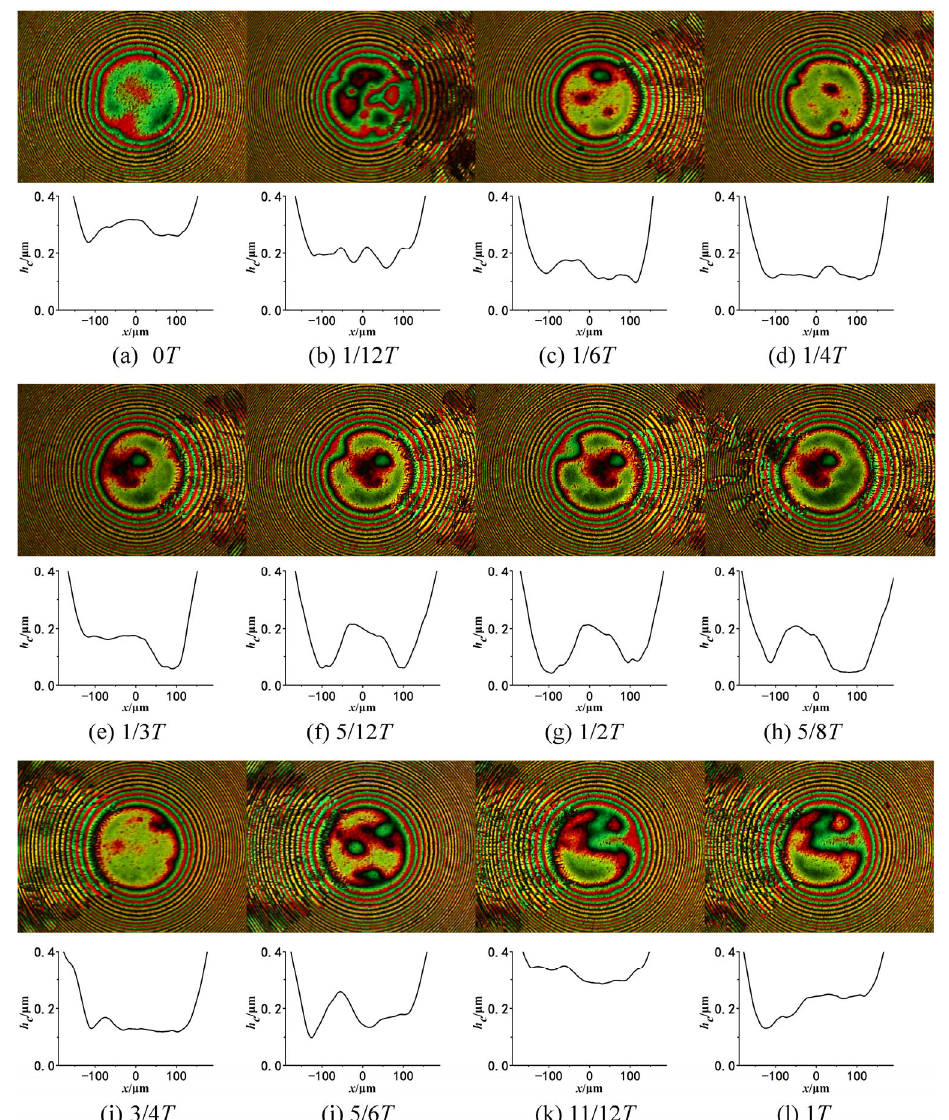
Fig. 5 Interferograms and midsection film thickness during 1st cycle under pure rolling reciprocating motion ( v max = 0.01 m/s, w = 15 N, T = 0.5 s, L = 1.25